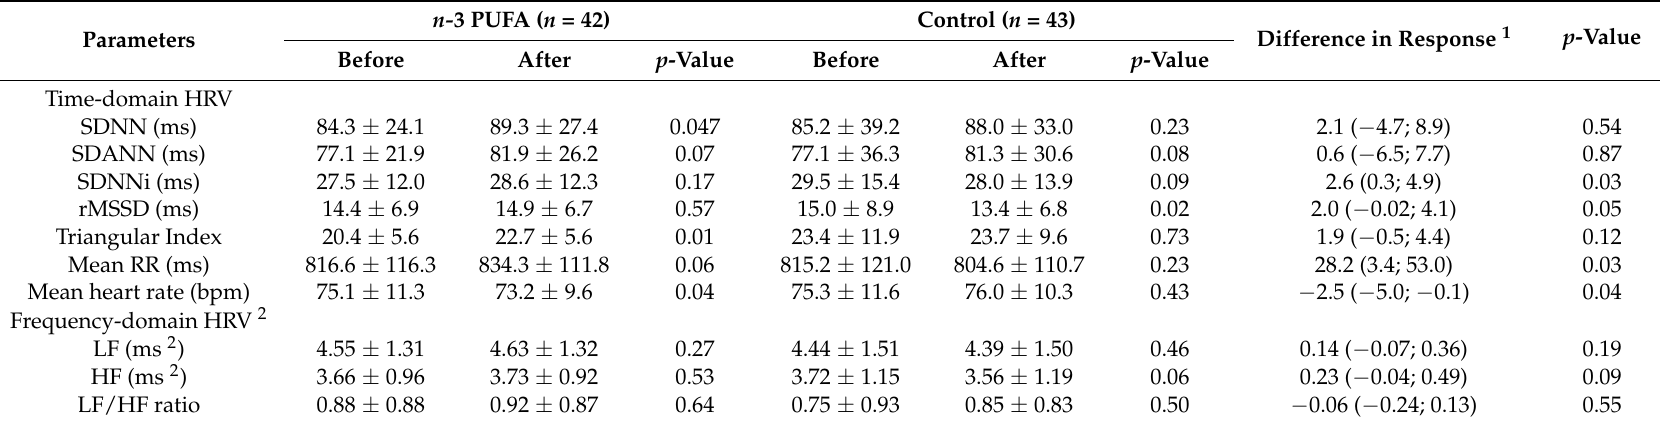
Difference in Response 1 p -Value